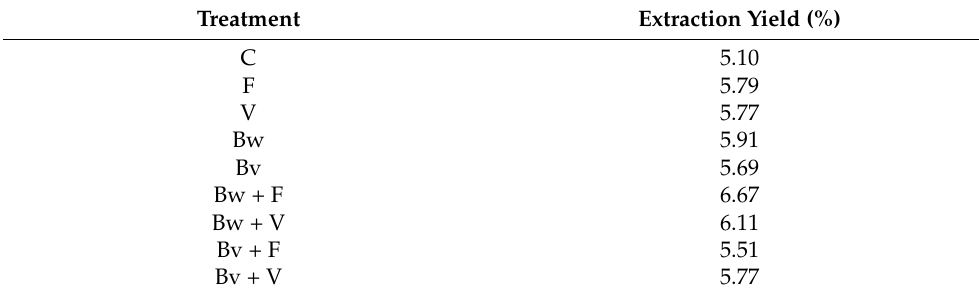
Table 3. Extraction yield of hydroalcoholic extracts from Swiss chard